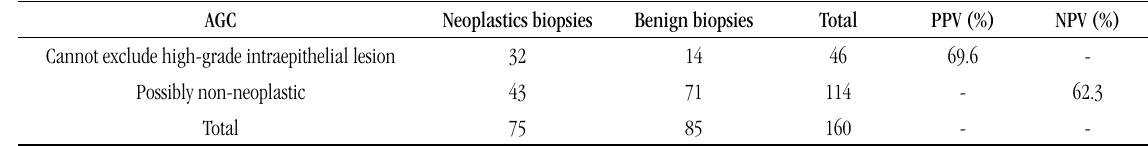
tABLE – PPV and NPV for AGC diagnosis “possibly non-neoplastic” and “cannot dismiss high-grade intraepithelial lesion”, according to cyto-histopathological correlation AGC Neoplastics biopsies Benign